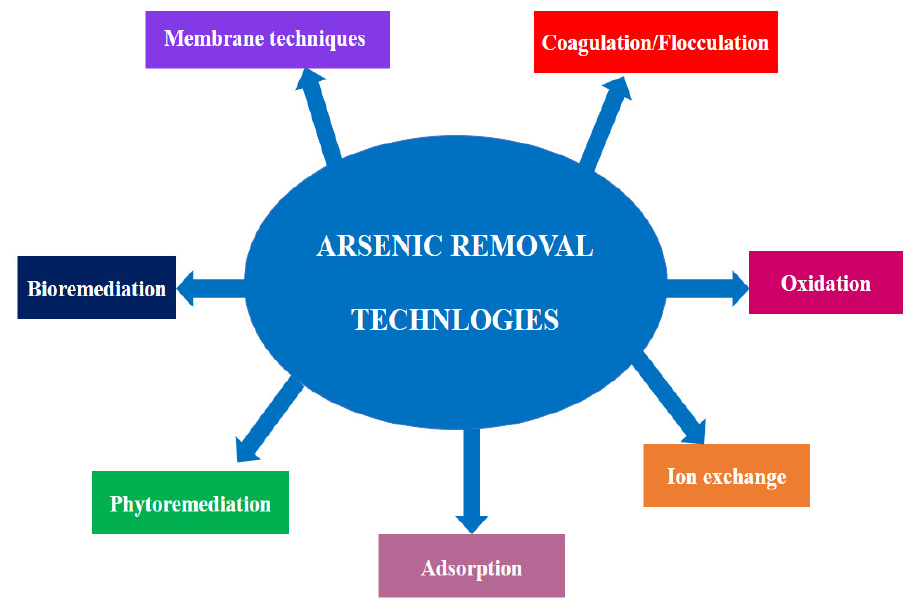
Figure 3. Various arsenic removal Figure 4. Various arsenic removal technologies.